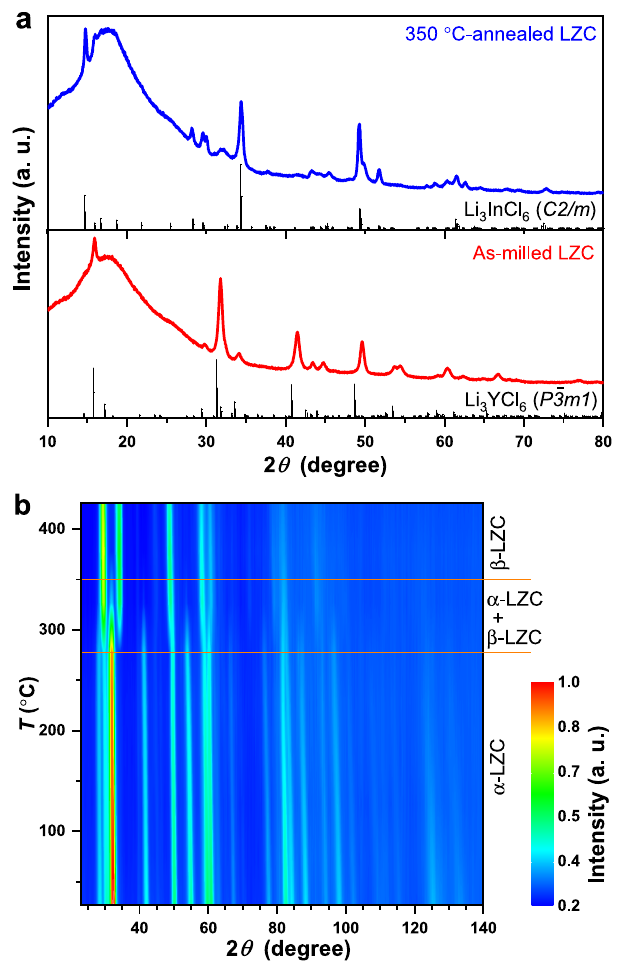
Fig. 3 Crystal structures and phase transition of LZC. a XRD patterns of the as-milled and 350 °C-annealed LZC. The broad hump below 30° comes from the Kapton fi lm that was used to prevent air exposure. The Bragg positions of Li 3 InCl 6 and Li 3 YCl 6 correspond to the structures reported in references 22 and 7, respectively. b Two-dimensional intensity color map of temperature-dependent NPD patterns for the as-milled LZC. The data were obtained in-situ between 27 and 427